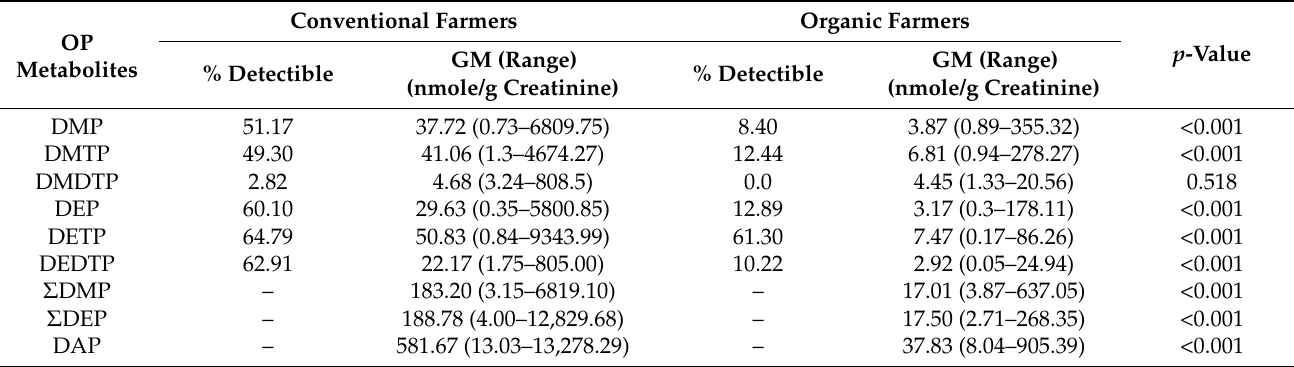
Table 3. Organophosphate metabolite comparison between conventional and organic farmers using independent t test on natural log of